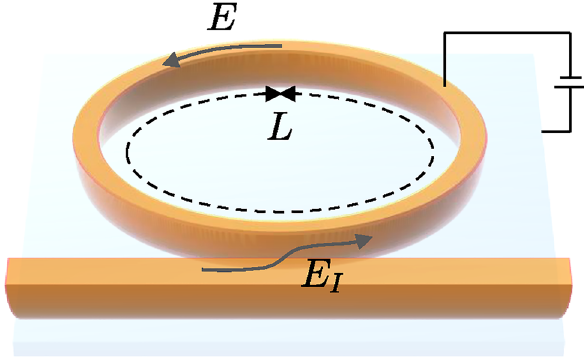
Figure 1: Schematic of a ring quantum cascade laser (QCL) under electrical bias with an injected optical signal. The ring cavity has a length L and the intracavity fi eld is E . The external fi eld E I is injected into the QCL from a straight